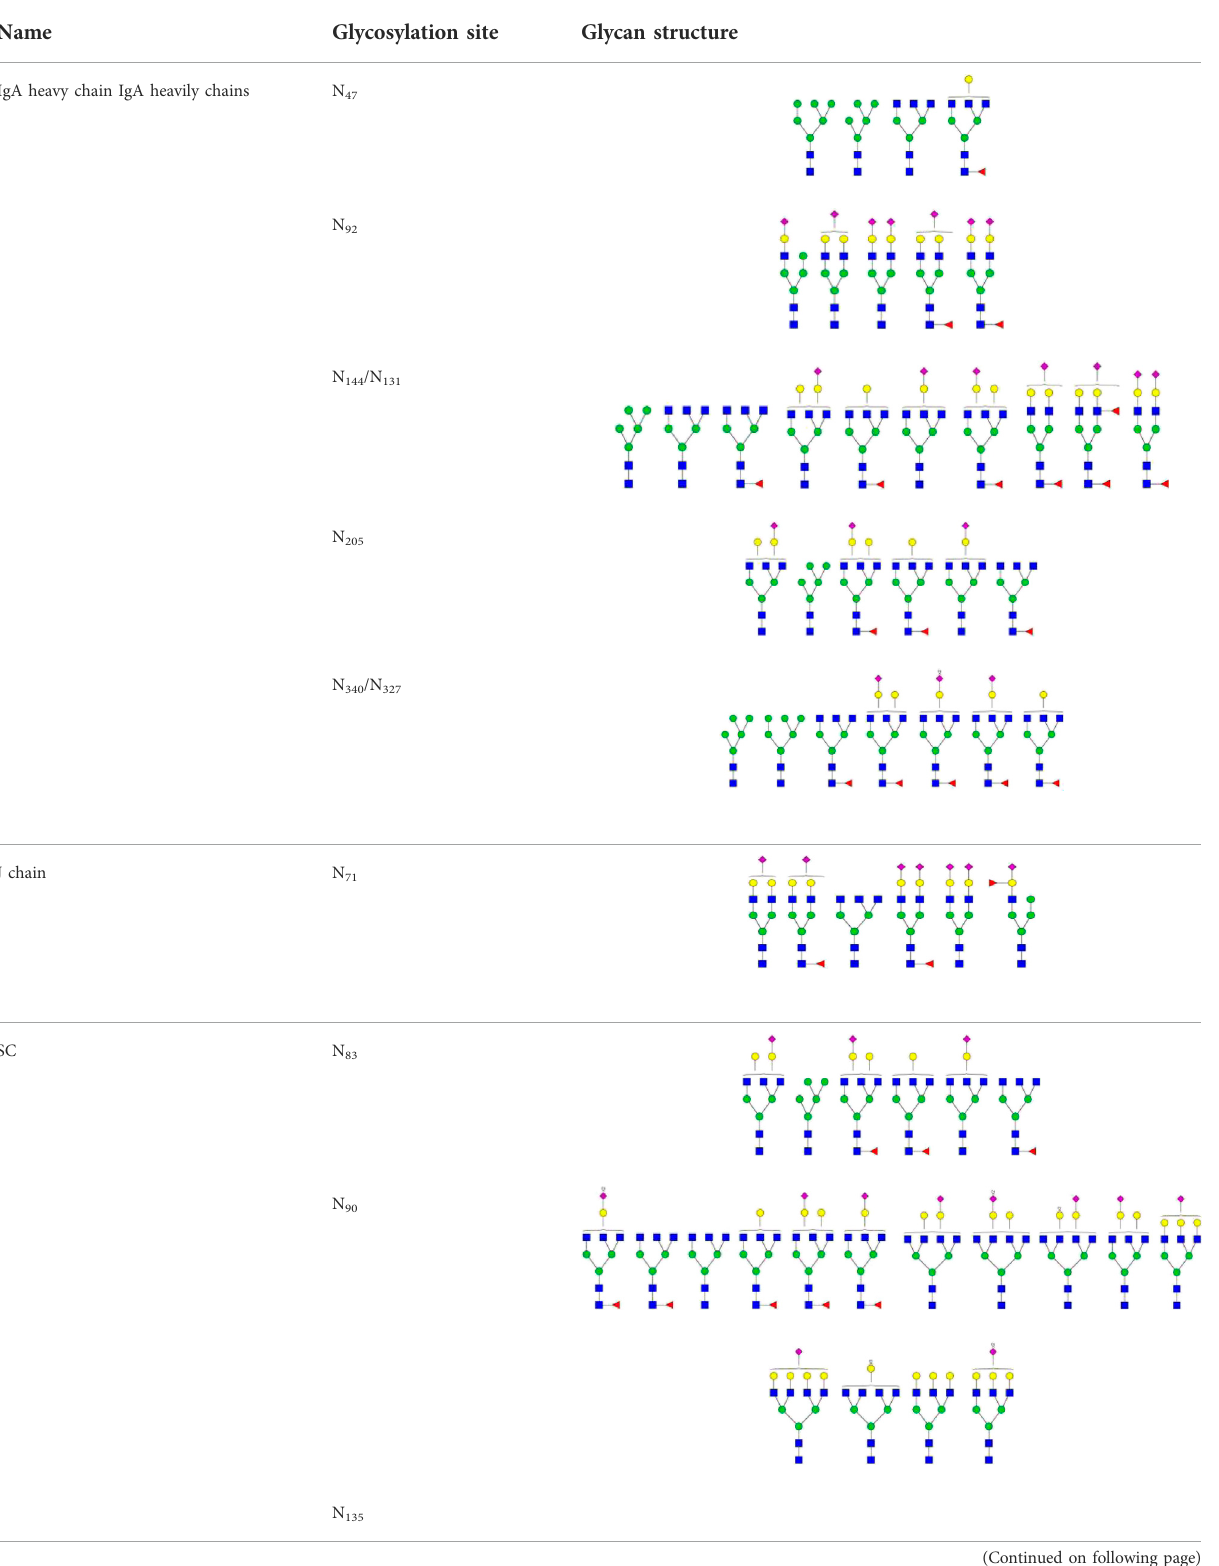
TABLE 1 The N-glycosylation sites and glycan structures on the heavy chain, J chain, and SC of IgA a .